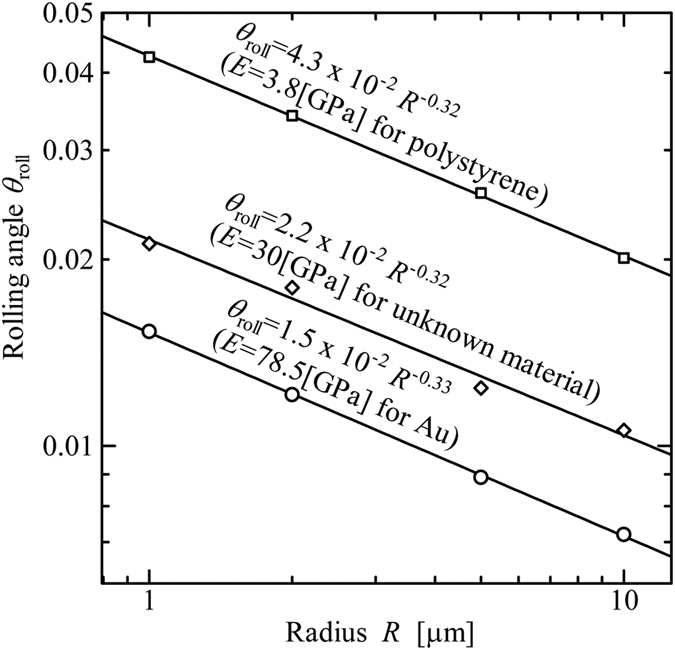
Rotational angle at the beginning of rolling θroll [rad].(Work of Adhesion: Δγ = 0.1 [N/m]).